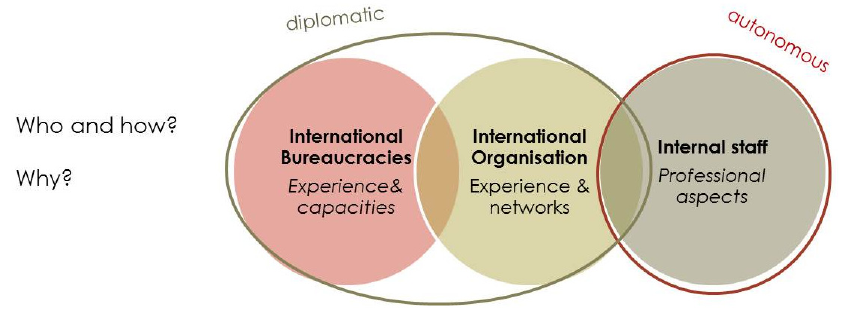
Figure 1. Administrative roles.